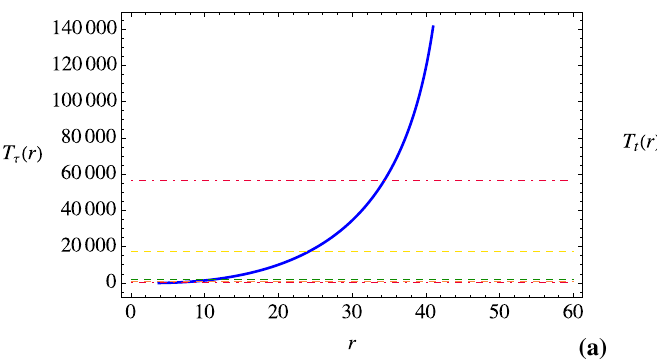
(lower line) and r C (upper line). The dashed lines cular orbits at r C 1 2 correspond to the stable circular orbits at r IS (orange), r OS (yellow) and